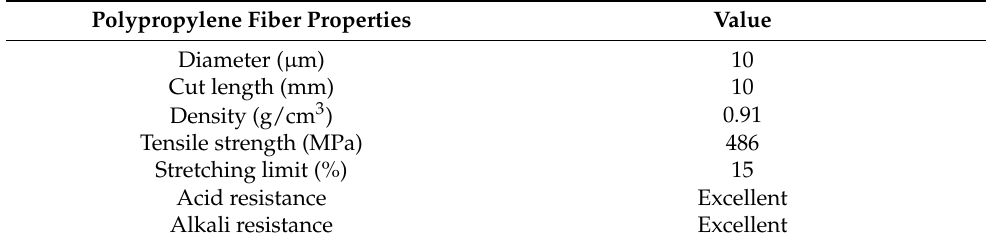
Table 2. Physical and mechanical properties of polypropylene